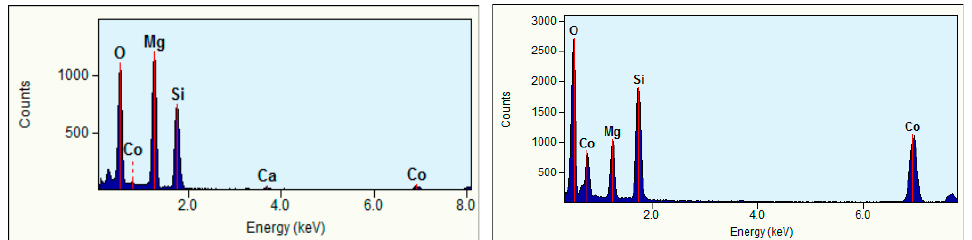
Figure 6. Representative STEM-EDS spectra of 360 min milled Mg 2 SiO 4 ( left ) and 360 min milled MgCoSiO 4 ( right ).